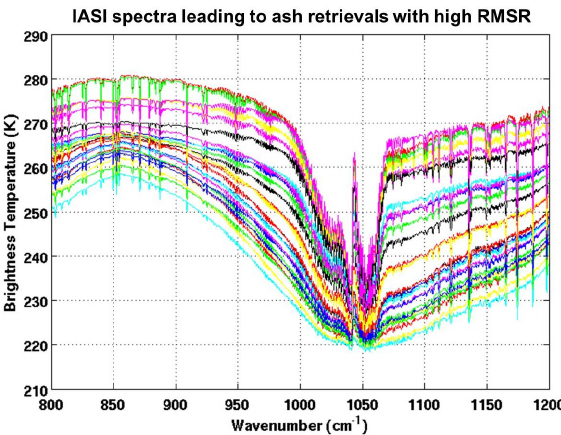
Figure 7. IASI measured spectra on 5 June, local morning overpass, in the area between 30 ◦ and 50 ◦ W, for which the ash retrievals were undertaken and resulted in a root mean square of residuals (RMSR) >10 K. Each line represents on single IASI